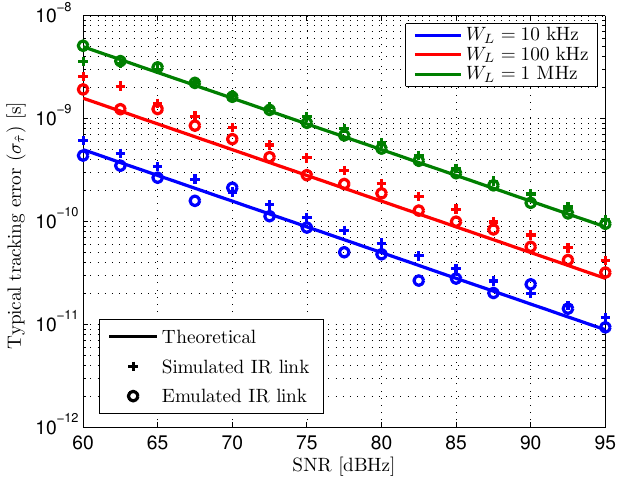
) caused by AWGN as a function of input SNR for Figure 11. Typical tracking error ( σ ˆ τ ) . Theoretical (solid), input signal from simulated IR-link different loop bandwidths ( W L (crosses) and input signal from emulated IR-link